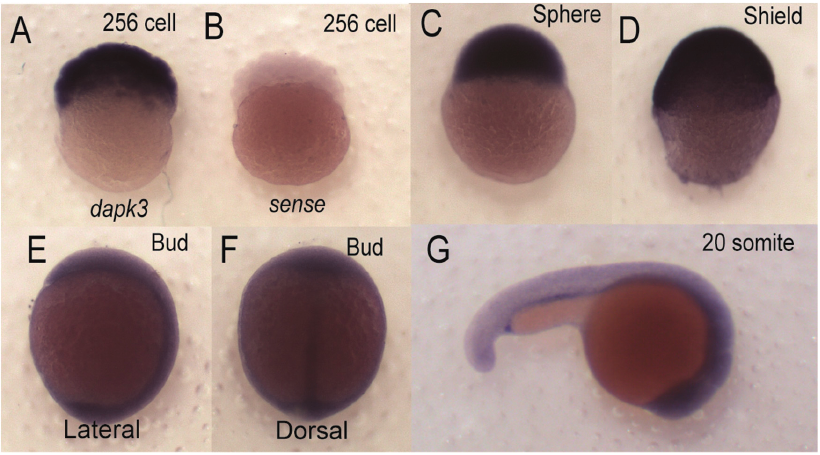
Figure 3. Spatial expression of zipk ( dapk3 ) during early zebrafish development. Detection of zipk mRNA ( dapk3 ) was carried out by whole-mount in situ hybridization using gene-specific probes on staged embryos at the 256 cells stage ( A ); sphere stage ( C ); shield stage ( D ); bud stage (( E ) lateral view and ( F ) dorsal view); 20 somite stage ( G ); Negative control sense probes for zipk did not show staining at the 256 cell stage ( B ) or other stages (data not shown). Because of the difference in expression maternal stages ( A – C ) were developed for a shorter time than zygotic stages ( D – G